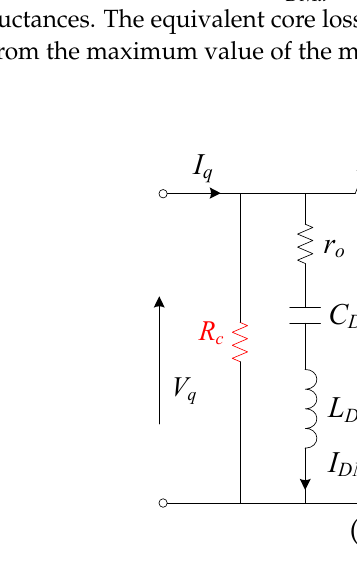
Figure 14. Differential mode ECM of PMSMs with predictable core loss: ( a ) d -axis; ( b ) q -axis [29]. Taking into account not only the copper loss and core loss, but also the PM loss, Ref. [30] introduced an ECM with a series-parallel structure, as shown in Figure 15. R Fe and R PM are the equivalent core loss and PM loss resistances, respectively, and they are indirectly achieved, based on finite element method (FEM) results.